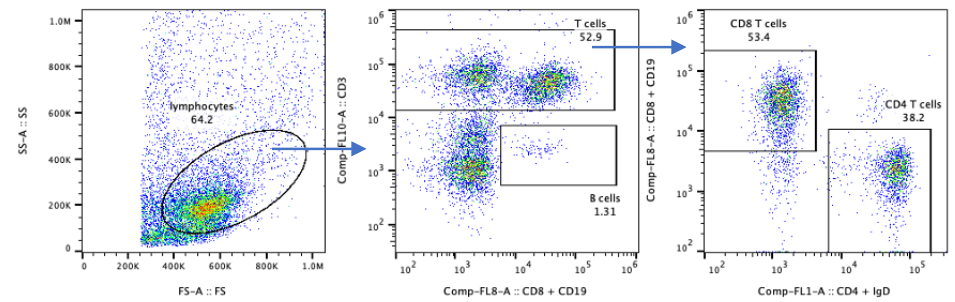
Figure 3. Gating strategy for muscle-isolated immune cell characterization by flow cytometry.